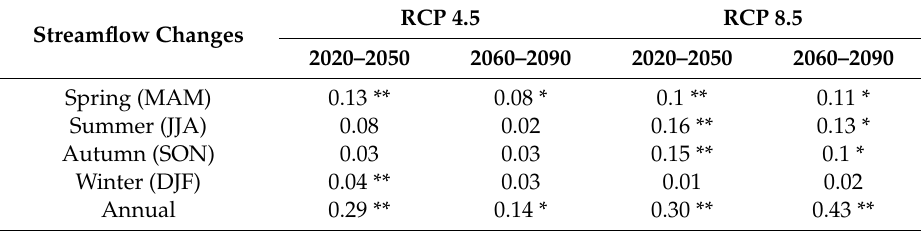
Table 3. Median future slope change from the results of Sen Slope assessment (mm/yr).